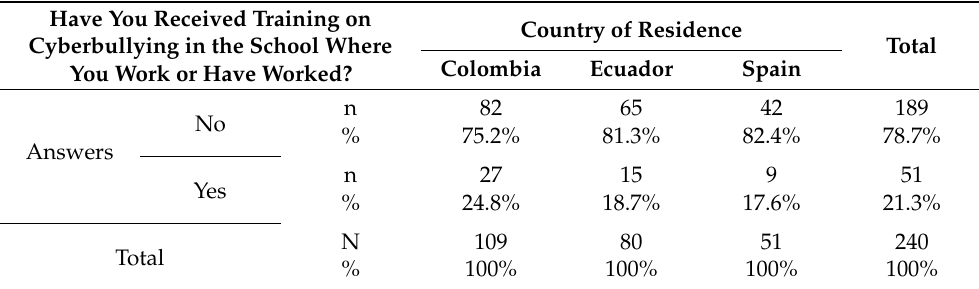
Table 7. Cross-categorization of the variable “Have you received training on cyberbullying in the center where you work” and the variable “Country of residence”.